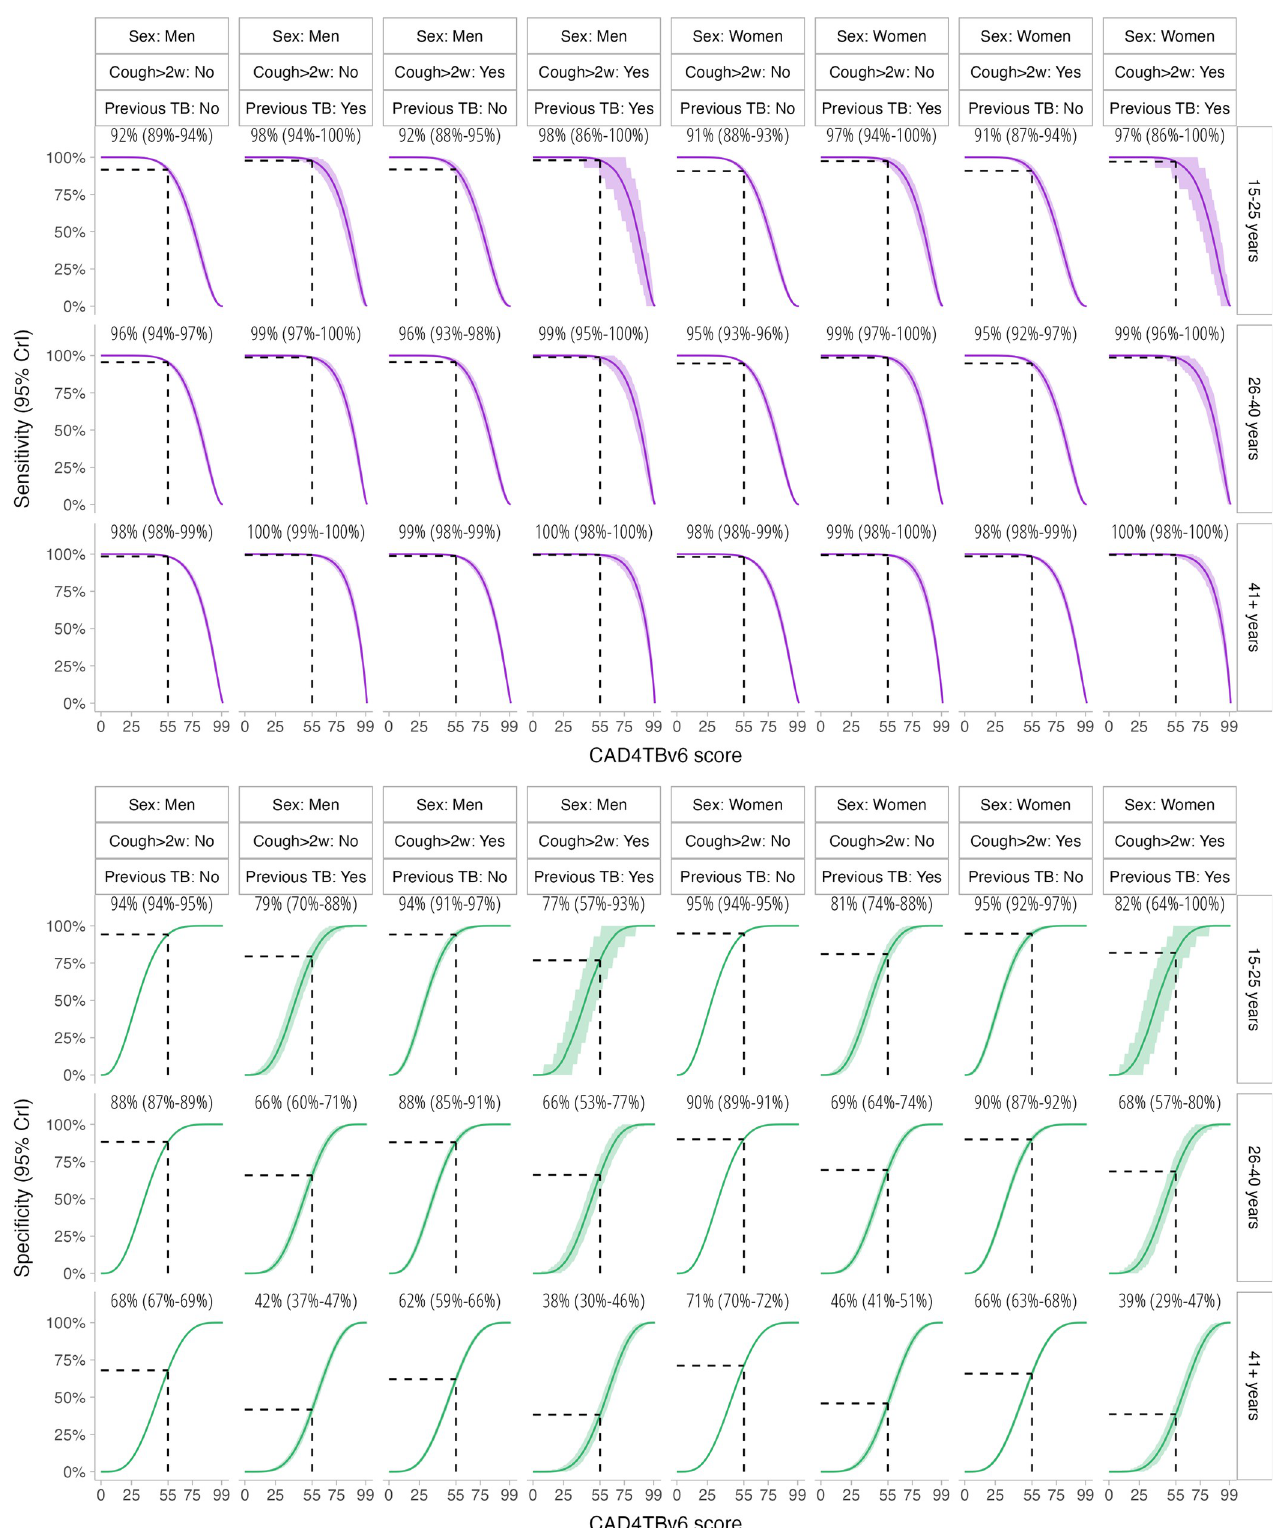
Fig 4. Sensitivity and specificity of CAD4TBv6 by prevalence survey participant characteristics, with threshold set at optimal target product profile to achieve overall sensitivity of 95% (CAD4TBv6 = 55).